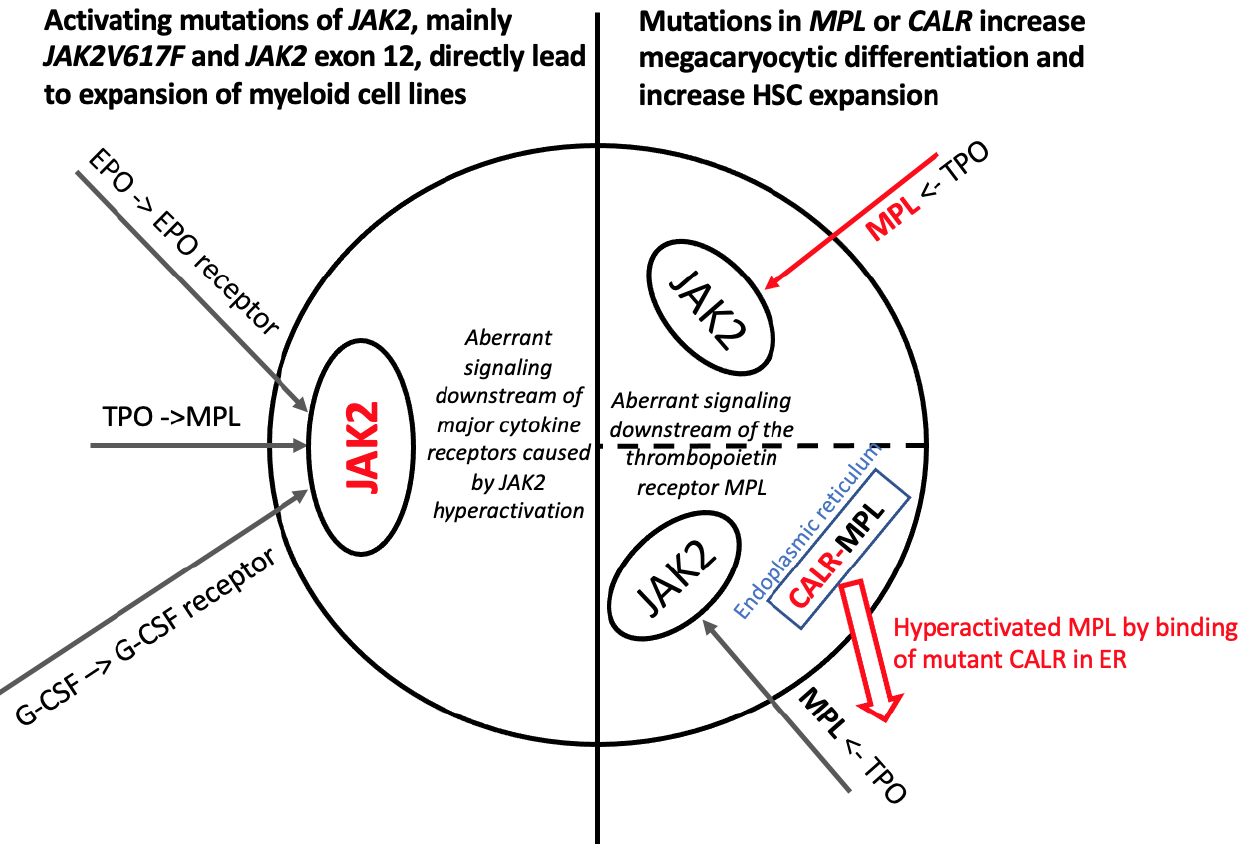
Figure 1. Schematic overview of hallmark mutations in MPN. JAK2 lies downstream of the EPO receptor, the thrombopoietin receptor (MPL), and the G-CSF receptor. The activation of JAK2 by a JAK2V617F or a JAK2 exon 12 mutations, therefore, enhances signaling downstream of pathways that would normally be activated by the growth factors for erythropoiesis, thrombopoiesis, or granulopoiesis. An activating mutation in MPL leads to increased signaling through the thrombopoietin (TPO)-thrombopoietin receptor-(MPL)-axis. Similarly, a mutation in the chaperone protein CALR leads to a constitutive activation of MPL upon binding of CALR to MPL in the endoplasmic reticulum (ER).